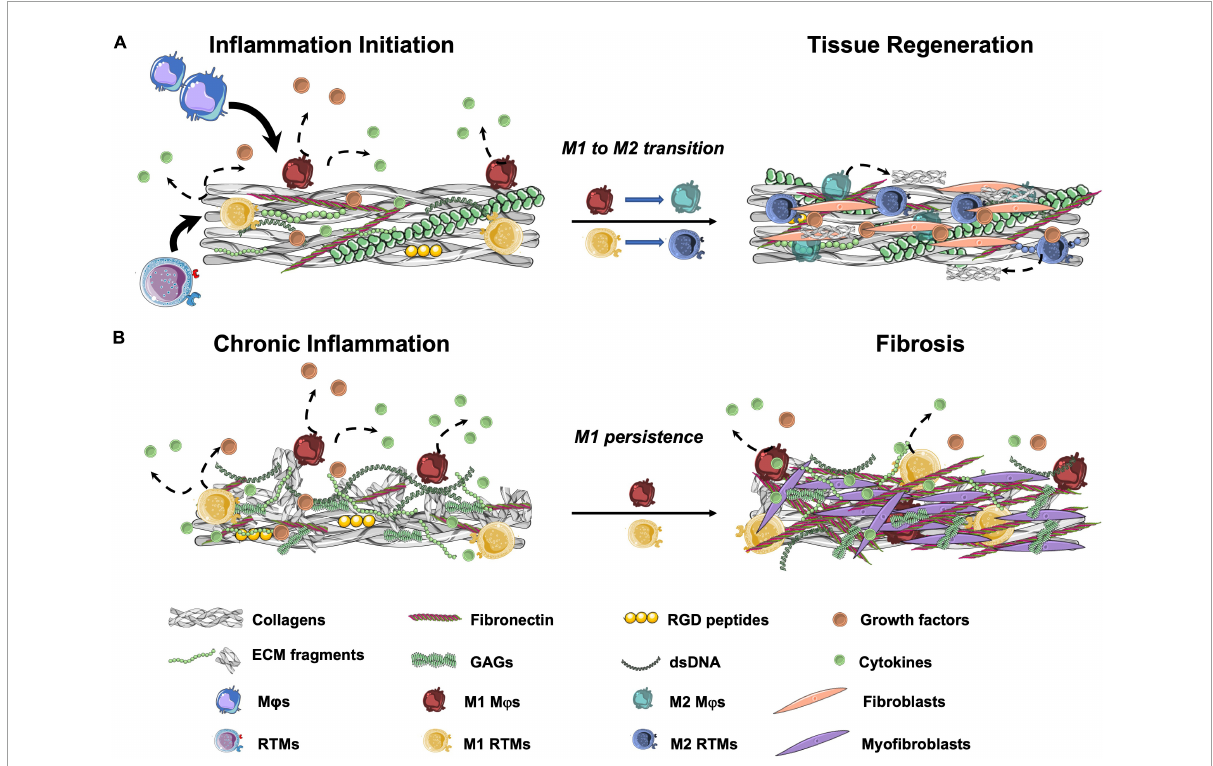
FIGURE2 Schematic representation of wound healing outcomes after tissue injury. (A) In normal wound healing cascades, resident tissue macrophages (RTMs) and circulation-derived macrophages (M ϕ s) are attracted to the damaged area. When in contact with cell debris and ECM fragments, RTMs and M ϕ s polarize to the M1 state and produce pro-inflammatory cytokines. After the initial pro-inflammatory response, M2 polarization with progressive resolution of the inflammation occurs. Among other stromal cells, fibroblasts are recruited to site to restore tissue integrity. (B) In the presence of a high amounts of ECM fragments, peptides, cell debris and/or DNA remnants, prolonged M1 polarization with limited or absent M2 transition occurs. This results in a chronic pro-inflammatory stimulation that leads to the production of unorganized collagen-rich ECM by the activated fibroblasts (myofibroblasts) and may cause tissue fibrosis. GAGs, glycosaminoglycans; RGD,